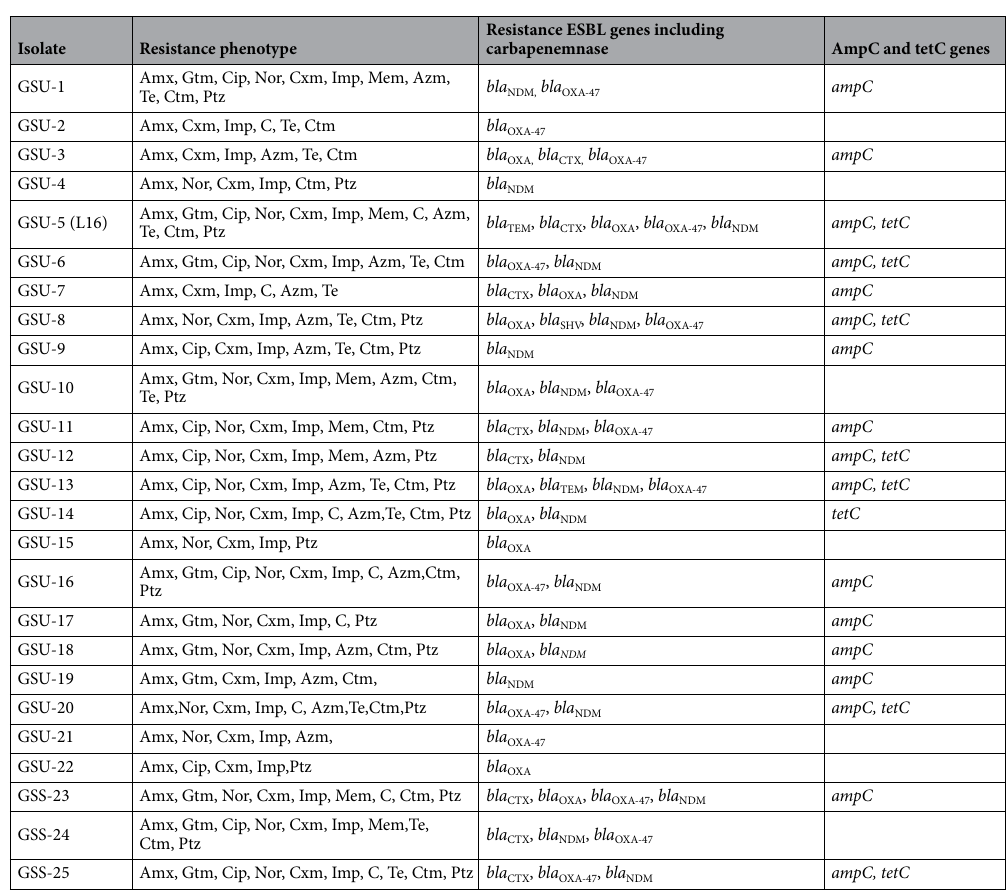
Table 2. Phenotypic antibiotic resistance and distribution of resistance genes among E. coli isolates. Amx amoxicillin, Cip ciprofloxacin, Gtm gentamycin, Imp imipenem, Mem meropenem, Nor norfloxacin, C Chloramphenicol, Te tetracycline, Ptz piperacillin & tazobactam, Cxm cefuroxime, Ctm cotrimoxazole, Azm azithromycin.